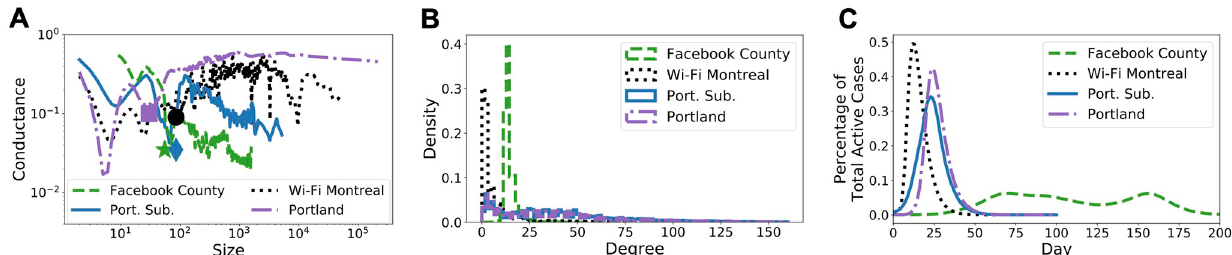
Fig 2. Characteristics of the original networks. (A) Network community profiles (NCPs, see Methods for a brief introduction). The NCPs have been computed using the Local Graph Clustering API [39, 40] based on the original paper [24]. The markers in the NCPs in Fig 2A correspond to tightly-knit clusters of nodes that we used to initialize the epidemic models for Fig 2C. (B) Degree distributions. (C) Predicted epidemic curves without